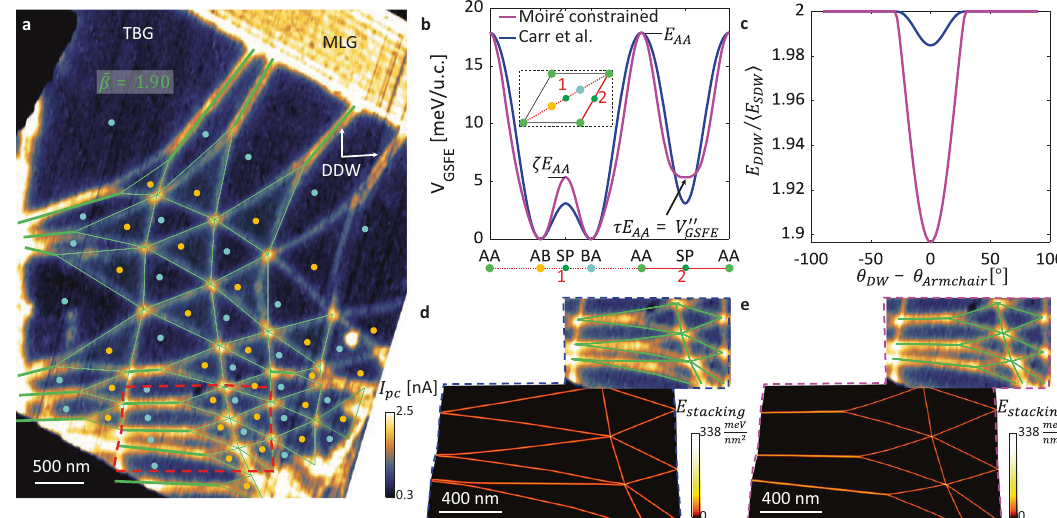
Fig. 2 Energy landscape of twisted bilayer graphene (TBG) revealed by the interplay between double (DDW) and single (SDW) domain walls. a Non- local nano-photocurrent map of moiré super-lattice of a TBG sample at the minimal twist limit (see “ Methods ” for more details). The technique reveals the formation of DDWs (marked by “ DDW ” ) at strained domains, separating domains of identical stacking con fi gurations (each con fi guration is indicated by dots of a given color [AB — orange, BA — cyan]). The green network overlaid on the data corresponds to the prediction by a single tuning parameter model with (cid:1) β ¼ 1 : 90 (see text and Supplementary Information S6). b GSFE of TBG from ref. 31 (blue) and a moiré constrained version (magenta). The unit-less parameters ζ , τ , spanning the phase space of GSFE candidates for TBG, are illustrated (see Supplementary Information S6). Inset: path in con fi guration space for presented GSFE line-cuts. c Effective attraction between SDWs as re fl ected by DDW to SDW energy ratios for different SDW orientations (relative to armchair direction) for both models. E DDW is the DDW line-energy for a DDW along the armchair direction and similarly E SDW is for the average of the two SDWs comprising the DDW. d , e Stacking energy density from 2D relaxation calculation (see “ Methods ” and Supplementary Information S2) for the two discussed GSFE choices ( d — literature, e — moiré constrained version with τ = 0.025, ζ = 0.3) of region marked by red dashed frame in ( a ), showing fundamental differences in formation of DDWs. Inset: extracted domain wall structures from relaxation calculations overlaid on experimental